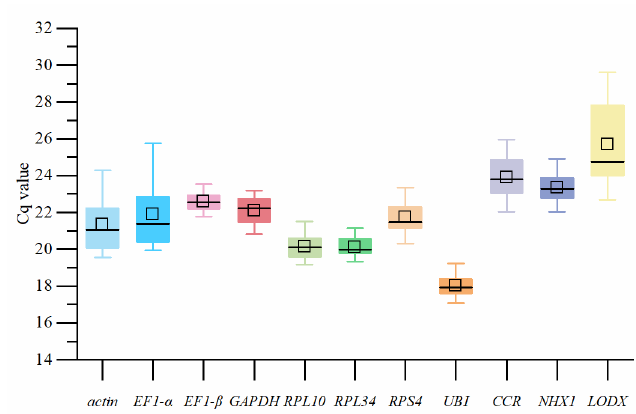
Figure 3. Expression level of candidate reference genes and target genes.